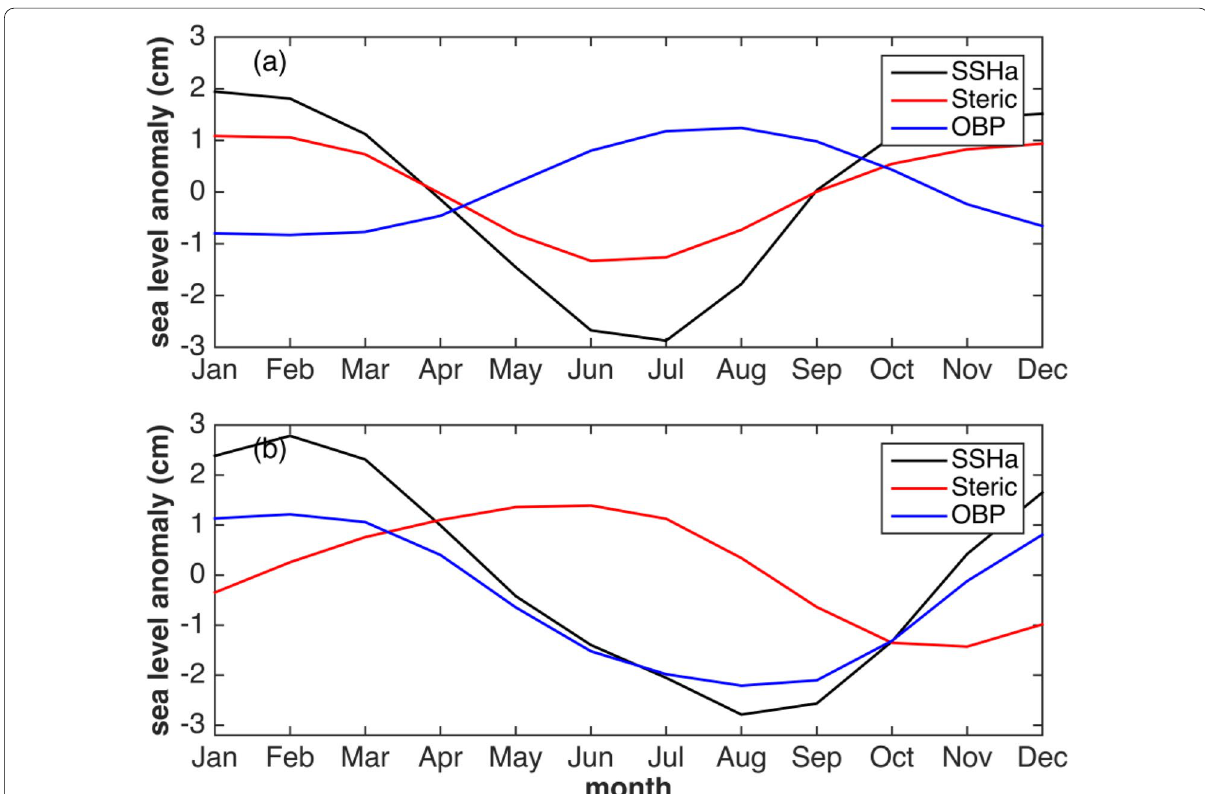
Fig. 2 a Annual cycle of sea level, steric sea level and ocean bottom pressure anomalies (cm) averaged in the tropical western Pacific (160° 10S ° 10 °N, Box A in Fig. 1a), b same as a but for anomalies in the southeastern southern Indian Ocean (80° −